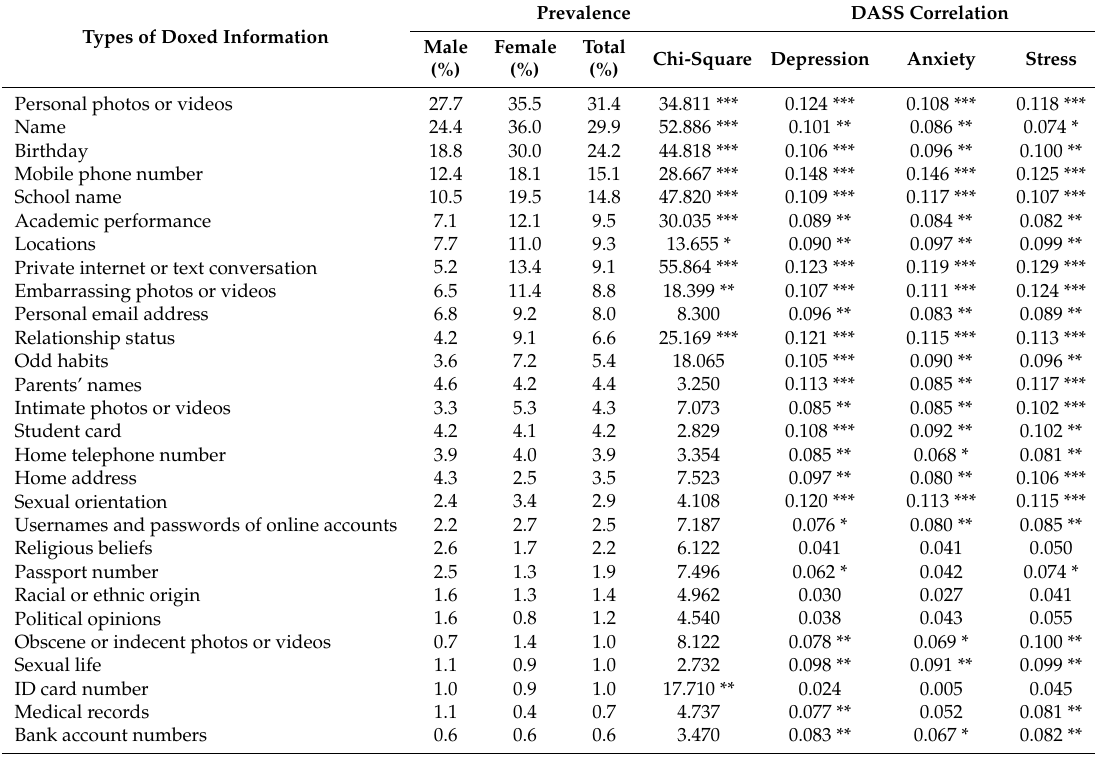
Table 1. Associations between types of personal information doxed (disclosed without consent) and DASS scores of victims ( n =